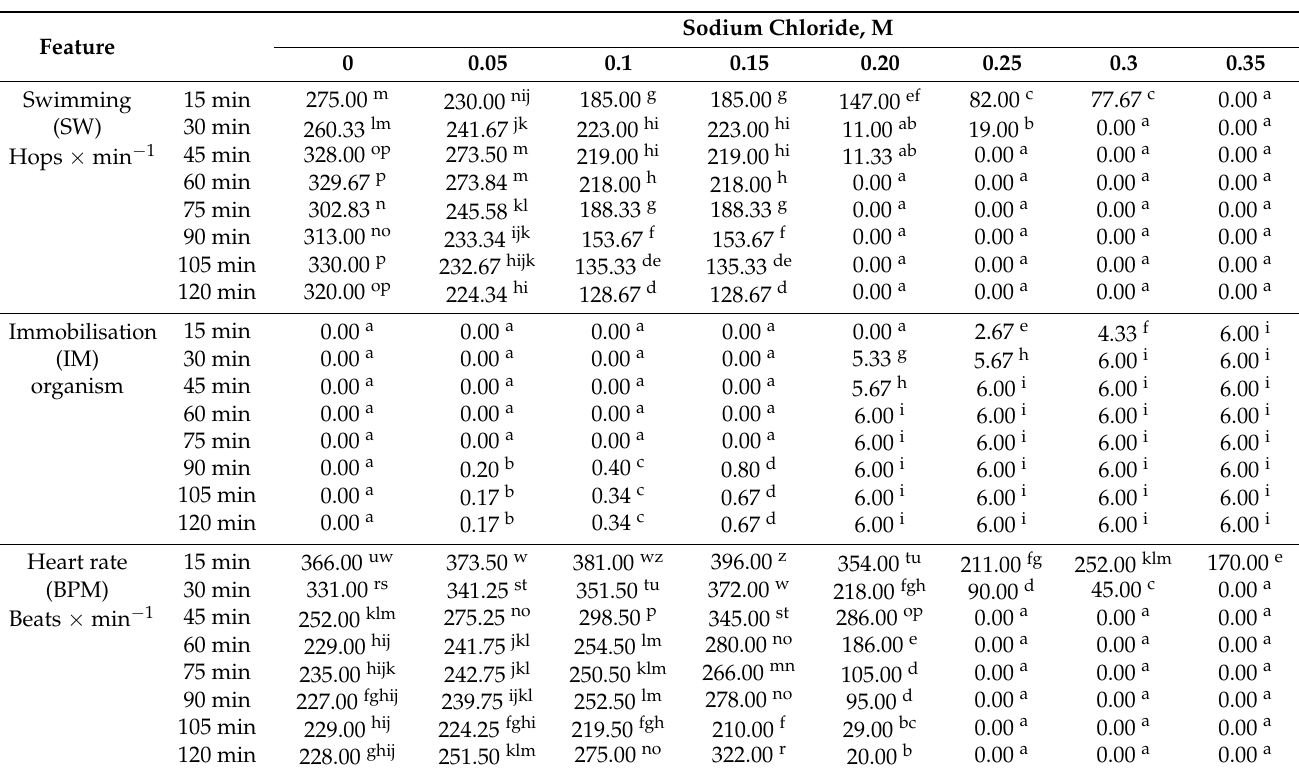
Table 6. The swimming (SW), immobilisation (IM) and heart rate (BPM) of crustaceans Daphnia magna exposed to sodium chloride (NaCl). The table contains the mean of the examined features and in superscript the level of significance